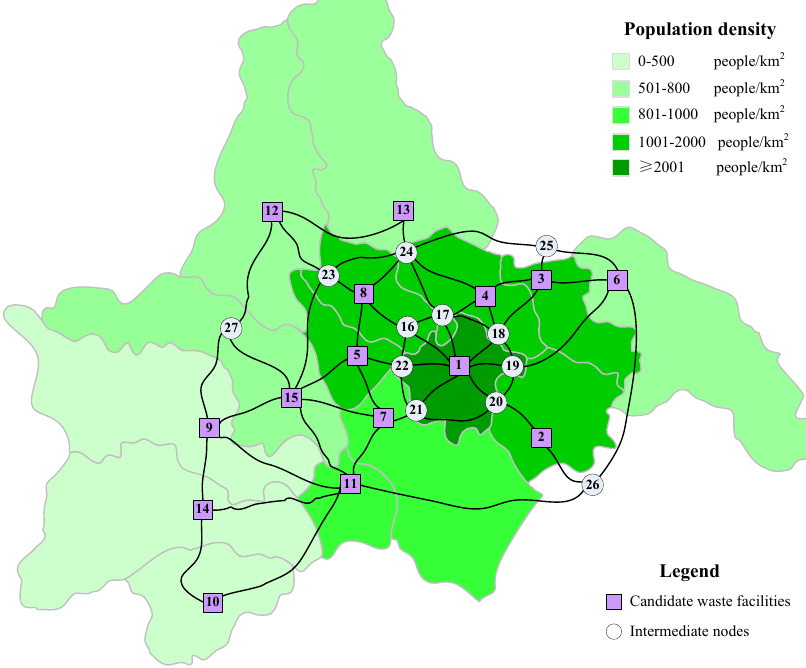
Figure 2. Test hazardous waste management